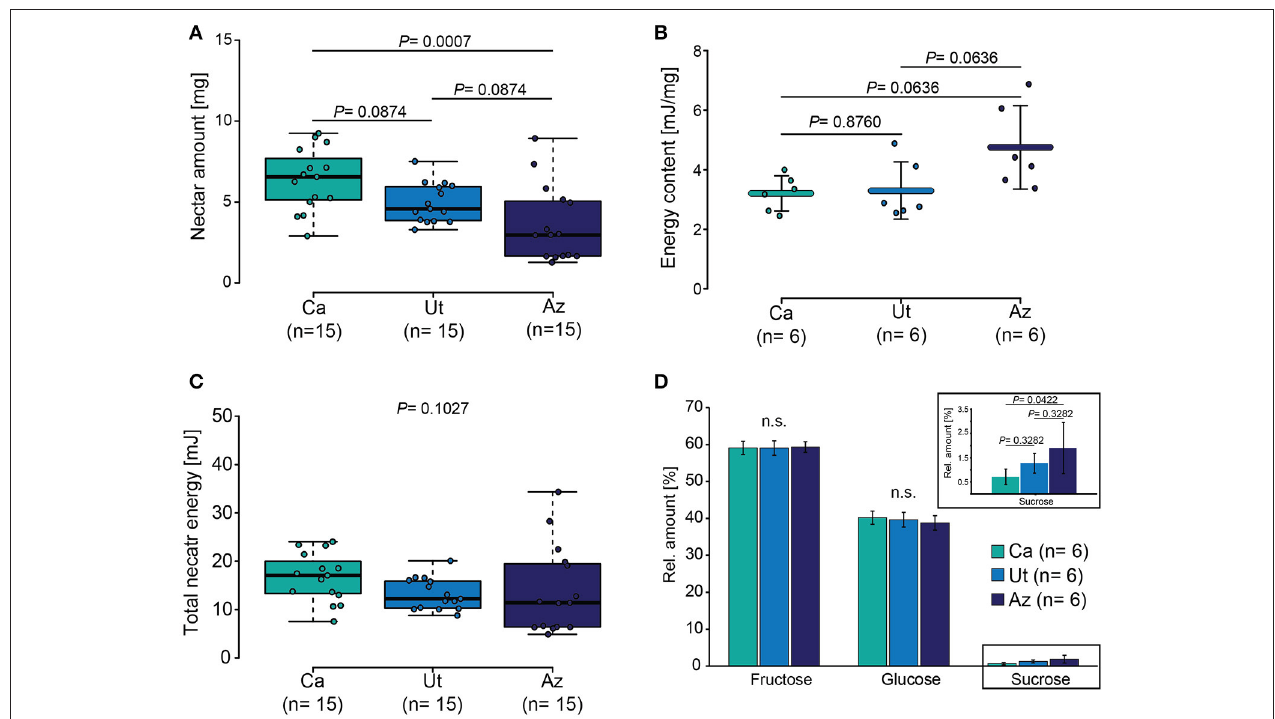
FIGURE 3 | Nectar properties of the three different N. attenuata populations. (A) Boxplot showing the median nectar amount, the 3rd and 4th quartile as well as the interquartile range. (B) Mean ± SD energy content per milligram of nectar. (C) Boxplot of the total nectar energy content. (D) Mean ± SD relative amount of each sugar type (fructose, glucose, and sucrose) in relation to the total sugar amount. Dots in all graphs show individual measurements. Parametric data shown in (B) was tested by ANOVA and non-parametric data shown in (C,D) by Kruskal – Wallis tests; pairwise cases were analyzed with Holm corrected LSD